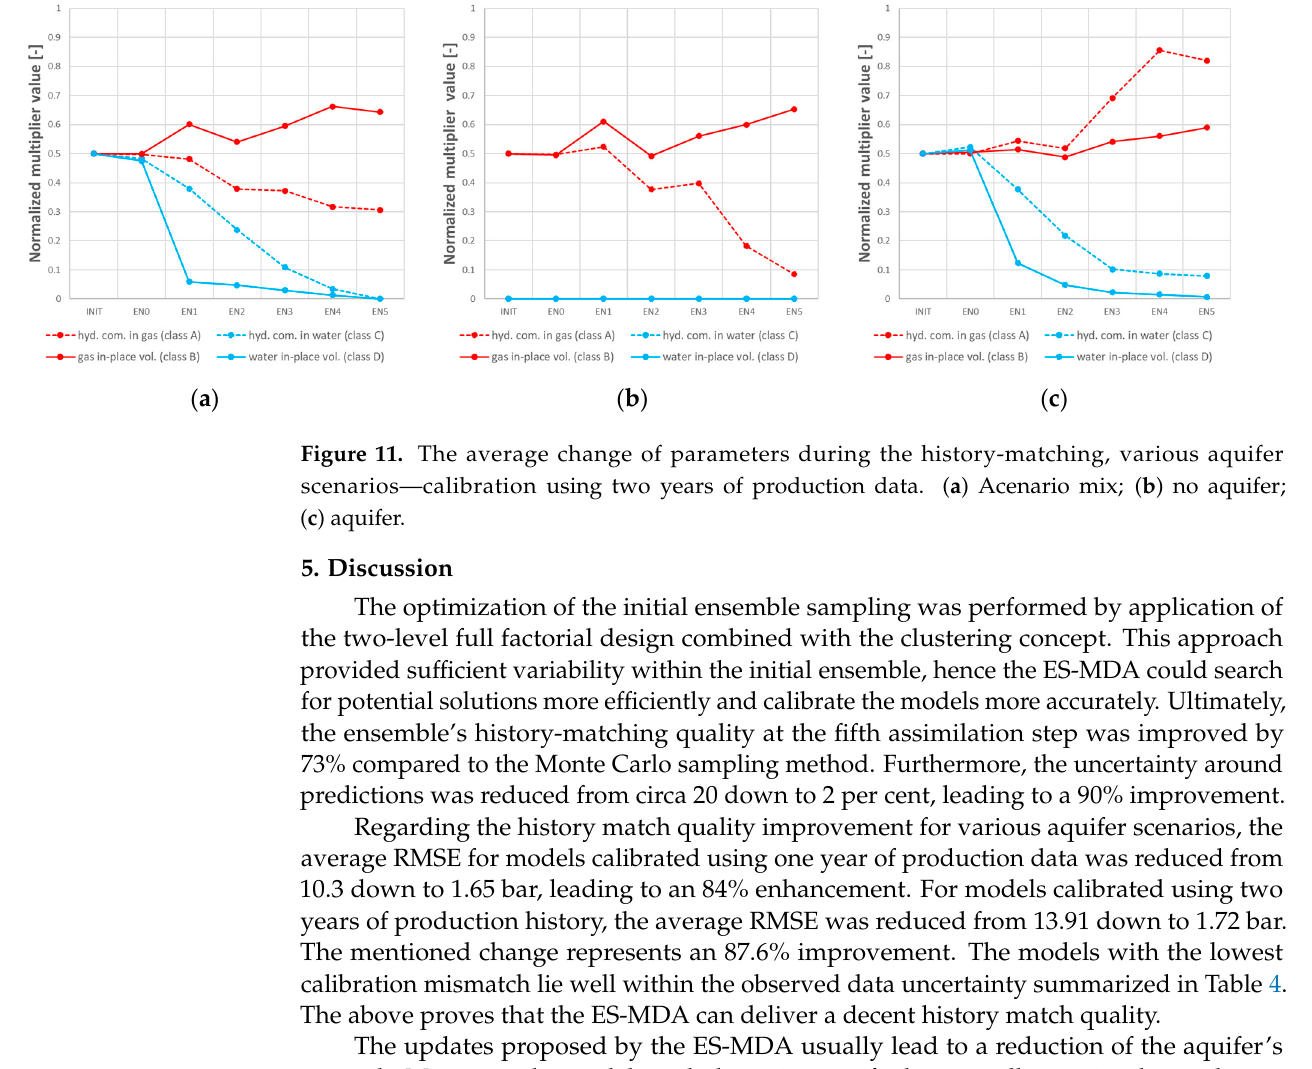
Figure 10. The average change of parameters during the history-matching, various aquifer scenar- ios—calibration using one year of production data. ( a ) Scenario mix; ( b ) no aquifer; ( c ) aquifer.